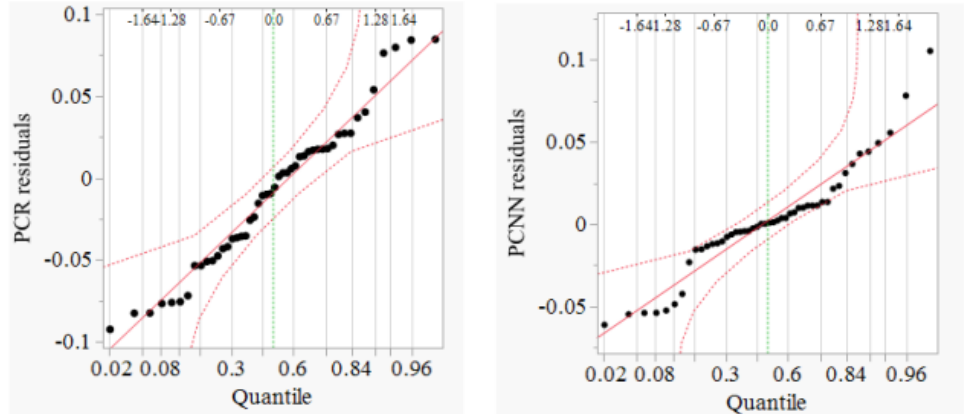
Figure 9. Checking the assumptions of independency using residual plot for PCR ( left ) and PCNN ( right ) models and the normality using normal probability plot of the residuals for PCR ( left ) and PCNN ( right )